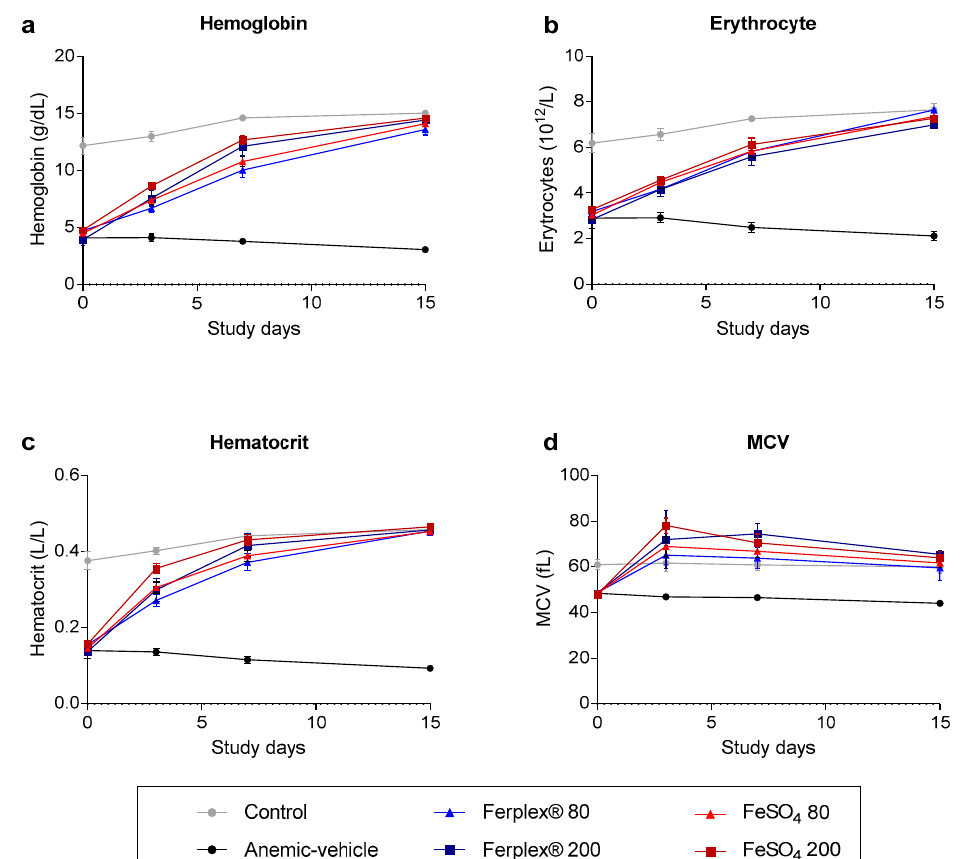
Figure 3. Complete blood count monitored during the treatment period. ( a ) Hemoglobin, ( b ) erythrocyte count ( c ) hematocrit and ( d ) mean corpuscular volume (MCV) measured in blood samples on days 0, 3, and 7 and at study termination on day 15. Data are presented as mean ± SEM. No significant difference was observed between treatment groups (Ferplex ® versus FeSO 4 ) and doses. Neither was any significant difference detected between treatment groups at any time point. At termination there was no significant difference between treatment groups and control. Data were analyzed by means of a Kruskal-Wallis test followed by Dunnett’s multiple comparison test. N = 5–8.